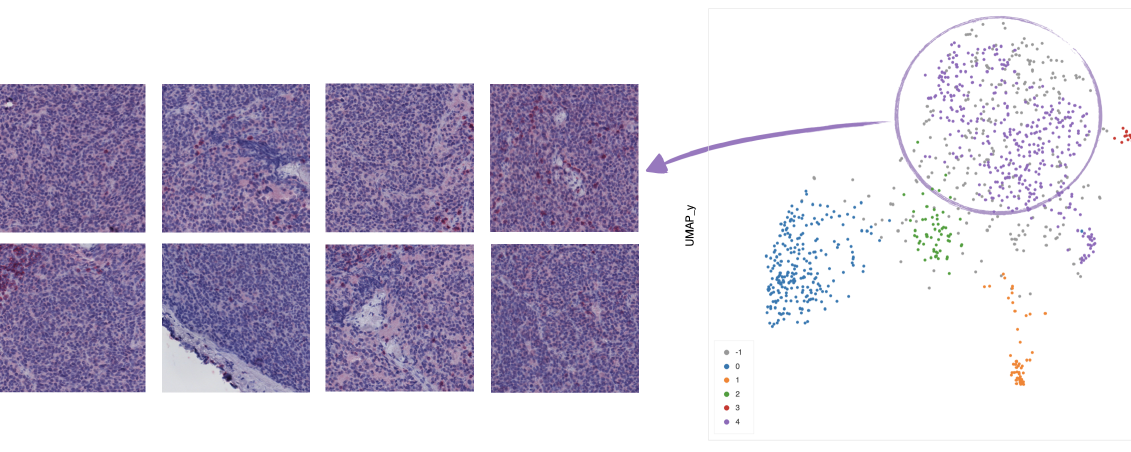
Figure 12. Example of 8 representative tiles with an intermediate level of lymphocyte infiltration in stroma poor areas, grouped as cluster 3 by UMAP and HDBSCAN.